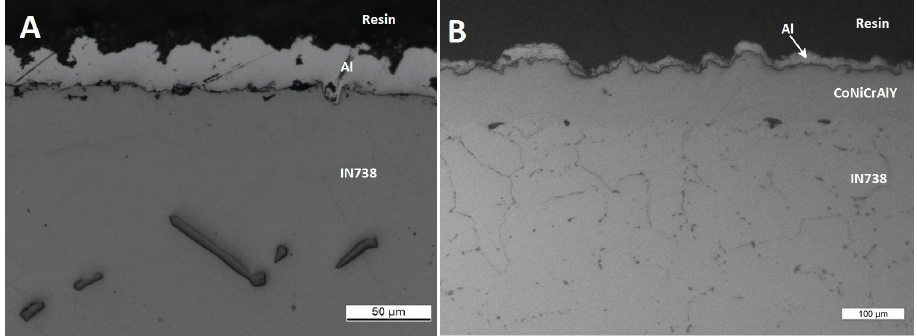
Figure 1. SEM images (SE signal) of the aluminum coating on bare IN738 ( A ) and CoNiCrAlY coated IN738 ( B ) before the heat treatment. In both cases, a pure Al layer about 20 μ m thick is detectable on the top of the sample.